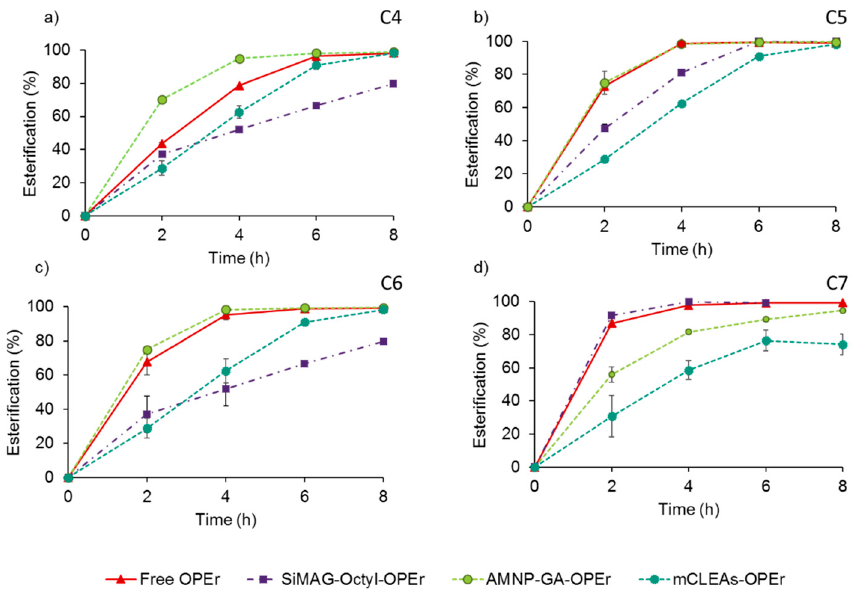
Figure 1. Comparison of the time-course of the esterification reactions, catalyzed by free OPEr and three preparations of the same enzyme immobilized on magnetic nanoparticles. The substrates were 1-butanol and 100 mM of the acids in isooctane: ( a ) butanoic (C4); ( b ) pentanoic (C5); ( c ) hexanoic (C6); and ( d ) heptanoic (C7) acid. Reactions (final volume 500 µL) were performed at 100 rpm and 25 °C, with 11 U of catalyst and a 2:1 molar ratio 1-butanol: VFA (volatile fatty acids).